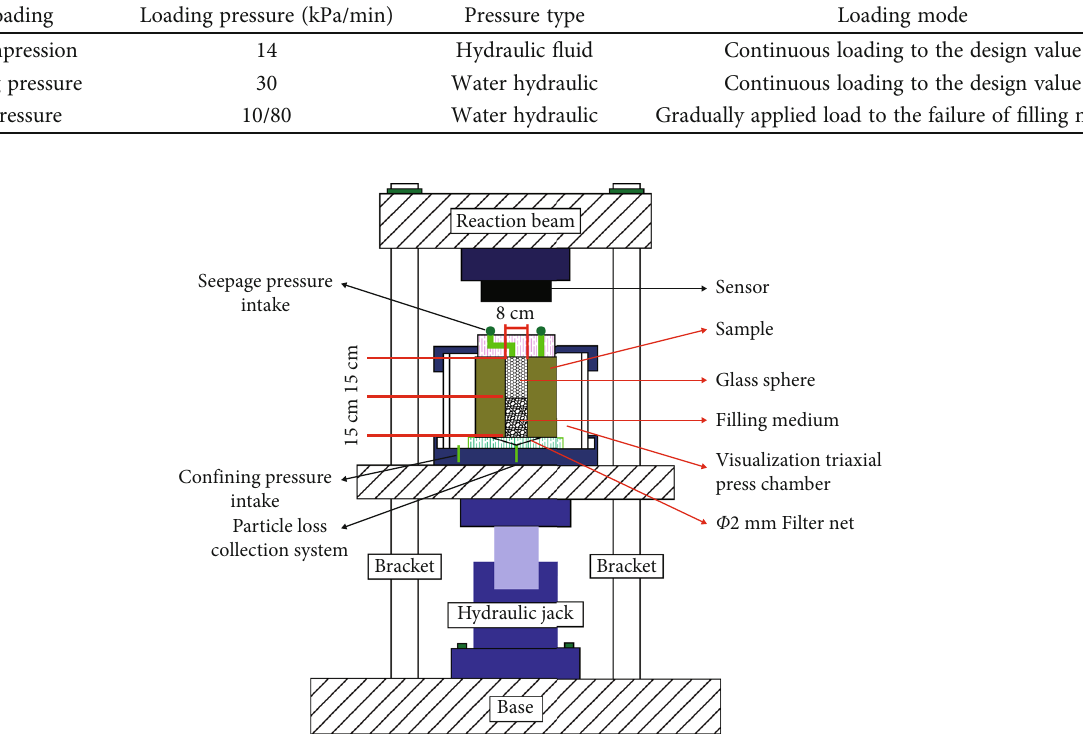
Figure 4: Schematic diagram of a test